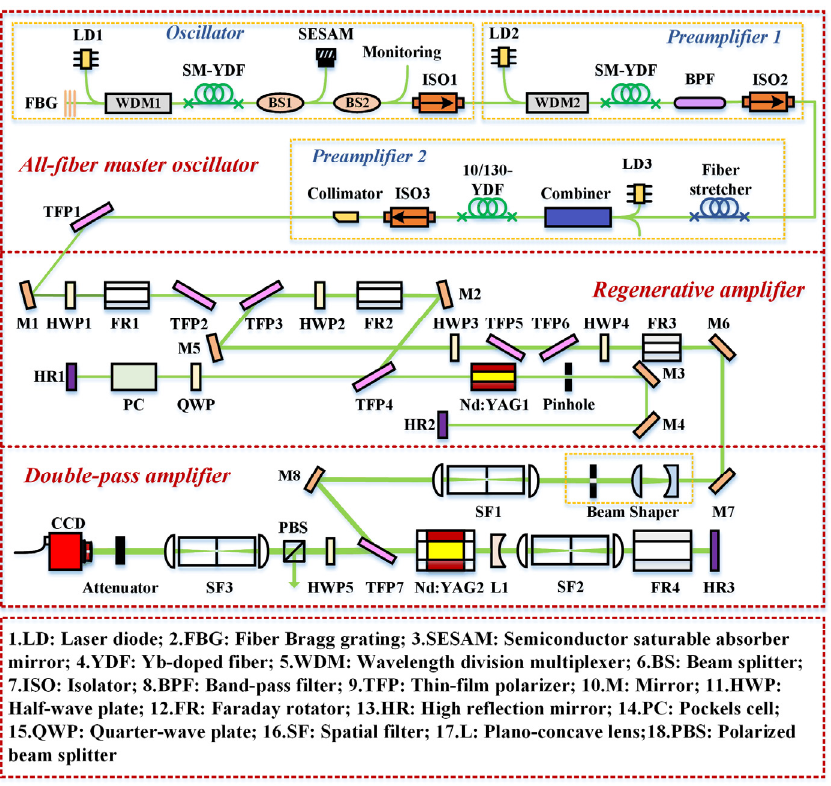
Figure 1. Schematic diagram of fiber–solid hybrid master oscillator power amplifier system.